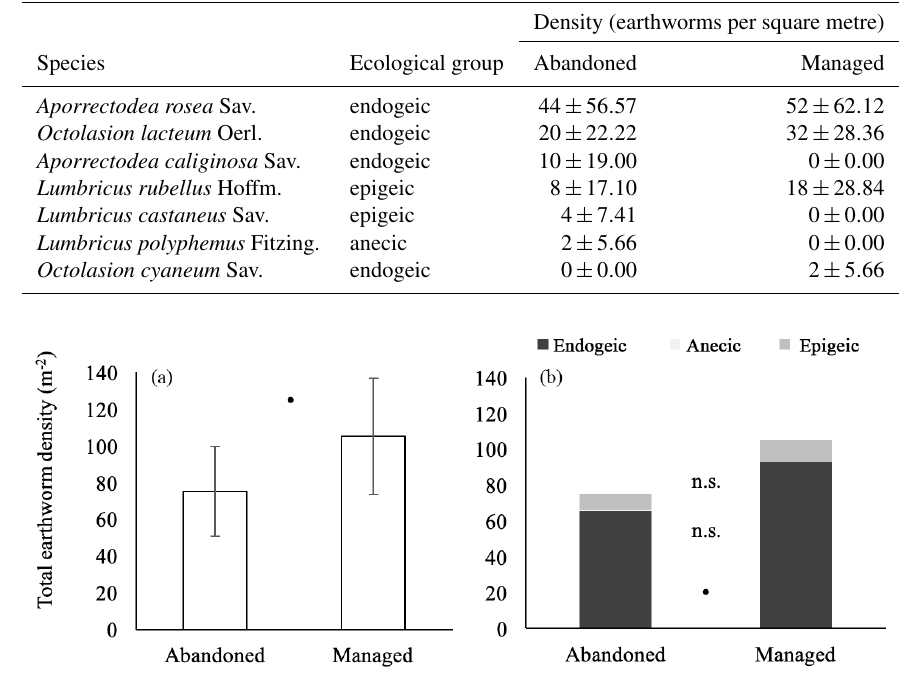
Figure 6. Total earthworm density (a) and density of ecological groups (b) in abandoned and managed meadows. Anecic earthworms are shown between endogeics and epigeics but hardly depicted. • denotes marginally significant difference between management types ( p < 0 . 1), n.s. no significant difference. Values are means ±